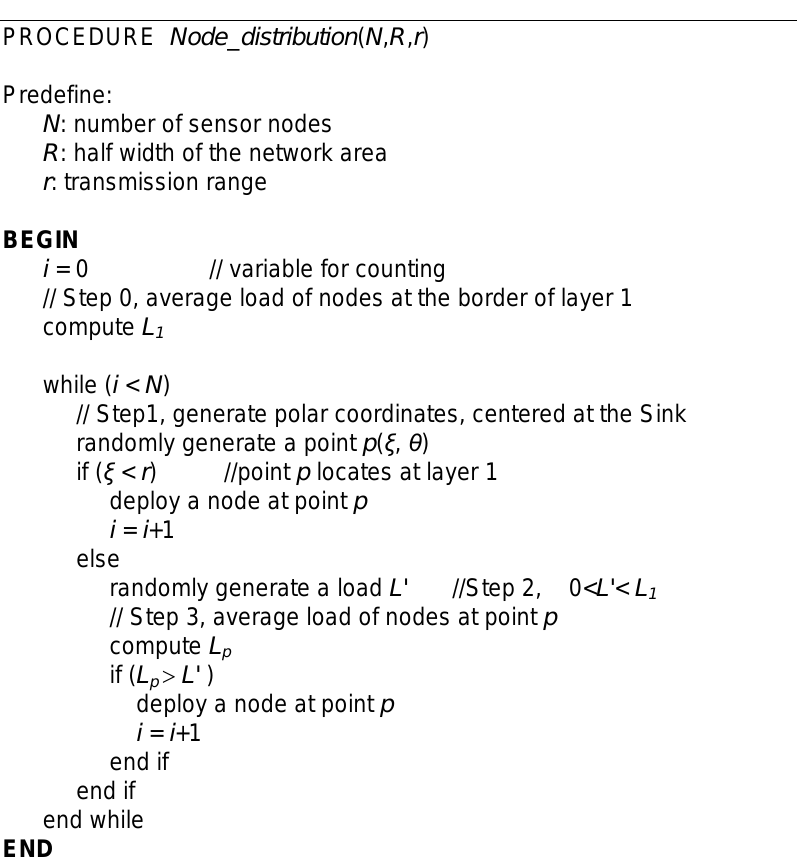
Figure 6. Pseudocode of load-similar node